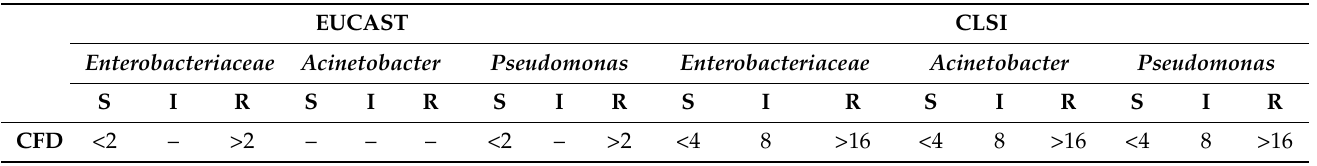
Table 5. Breakpoint values of minimum inhibitory concentration (mg/L) for cefiderocol according to guidelines in Europe (EUCAST) and the United States